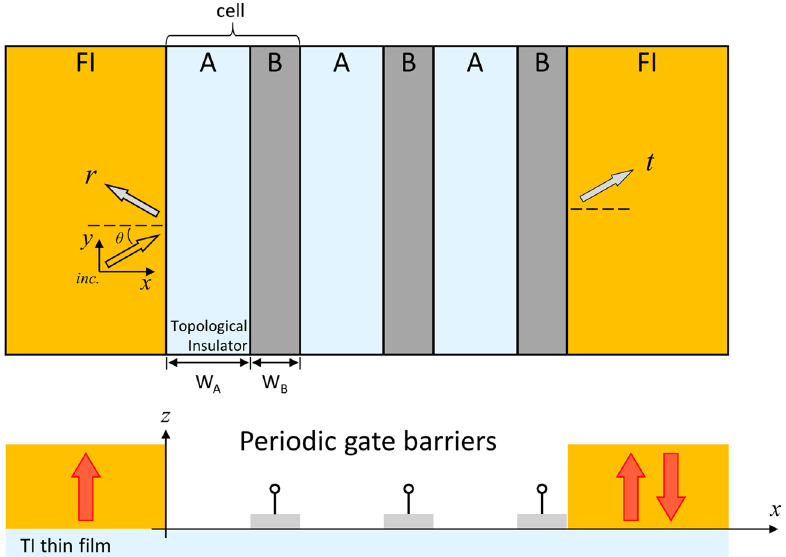
Figure 1. Schematic representation and device profile of a lateral TITF spin valve with a 3-cell top gate. The normal and top-gate potentials are taken as the unit cell (A/B) in this system. The top gates on the TI surface represented by the gray electrodes induce squared gate voltages V g . Spin electrons are injected into the spin valve with an incident angle θ